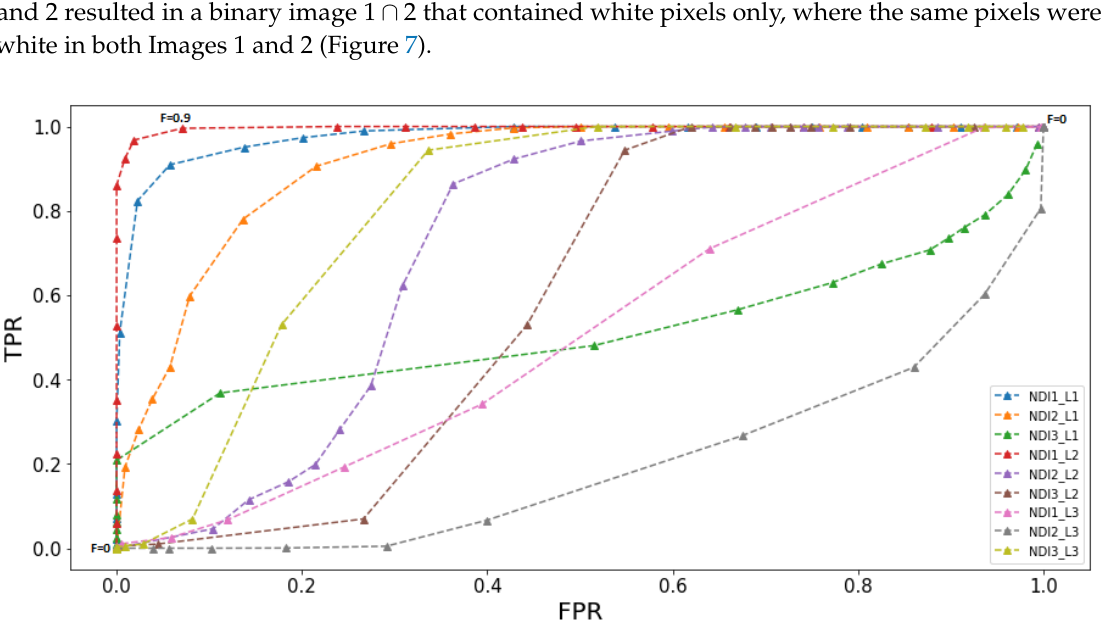
Figure 6. Nine ROC curves: 3 dimensions × 3 light levels NDI i − L j ; i represents the color space dimension; j represents the illumination